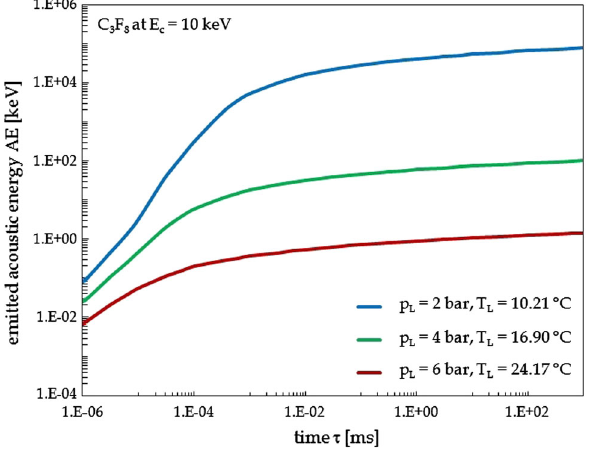
Fig. 4 Distributions of AE vs. time at E c = 10 keV using p L as a parameter